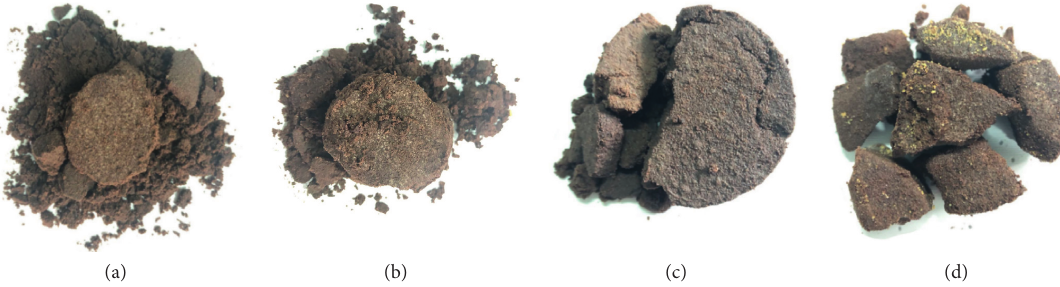
Figure 13: Failure modes of red sandstone at different temperatures: (a) 0 ° C; (b) − 10 ° C; (c) − 20 ° C; (d) − 30 °